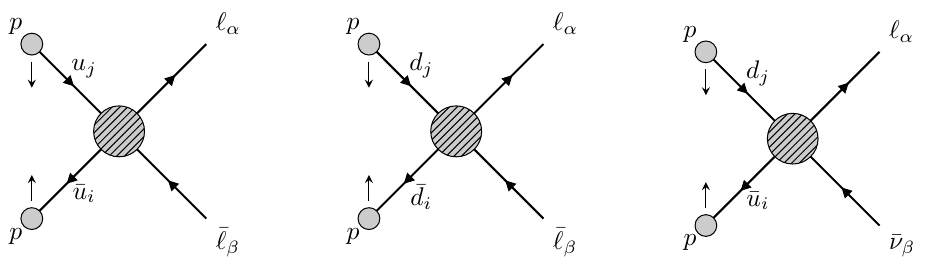
Figure 1. Neutral and charged Drell-Yan production processes at proton-proton